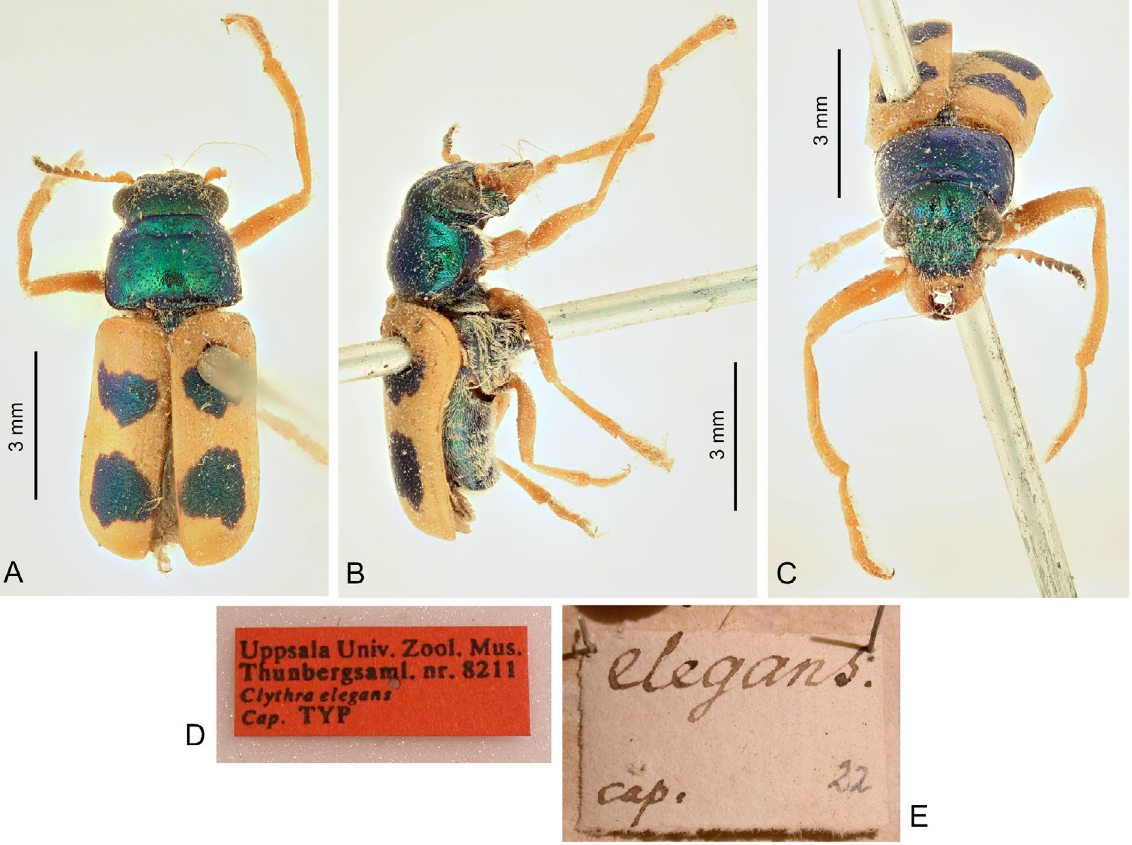
Fig. 2. Atelechira elegans (Thunberg, 1821), holotype, ♂, 7.5 mm, UUZM. A . Dorsal view. B . Lateral view. C . Frontal view. D . Label. E . Box